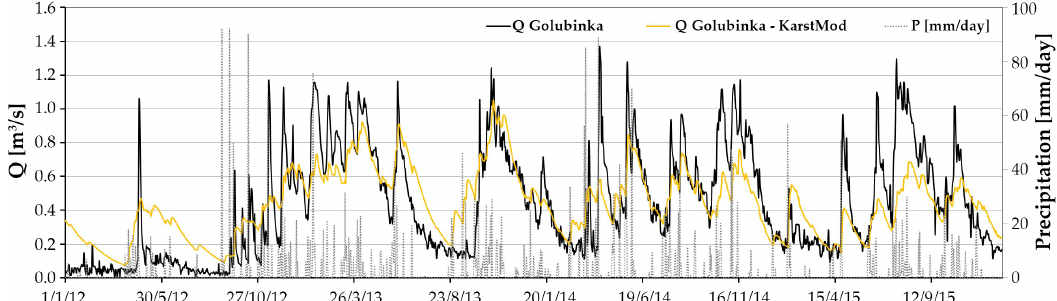
Figure 9. Discharge hydrograph of the Golubinka spring obtained by the KarstMod model simulation.